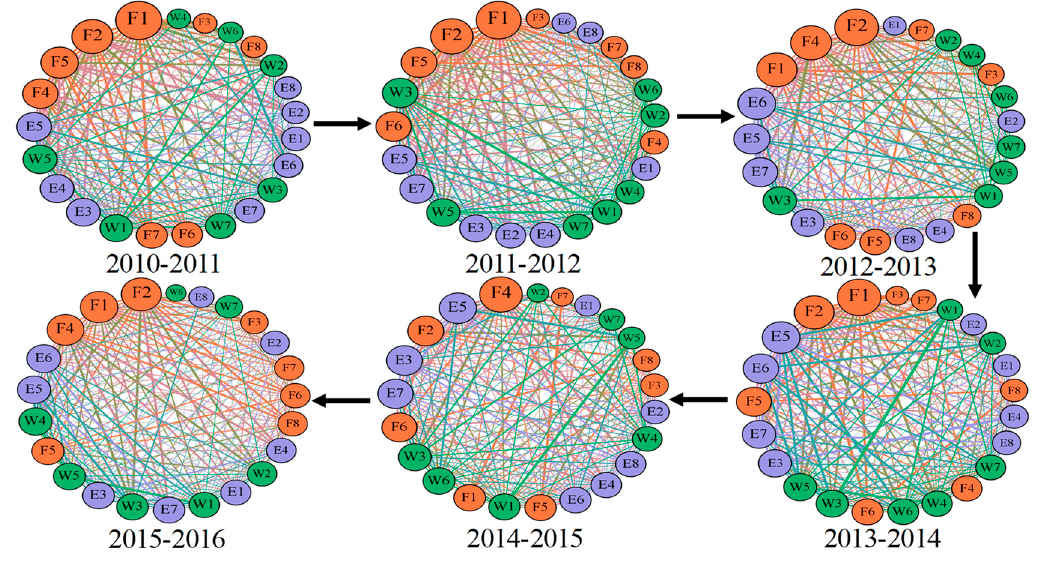
Figure 3. Evolution of synergetic networks in Shenzhen from 2010 to Figure 3 . Evolution of synergetic networks in Shenzhen from 2010 to 2016.